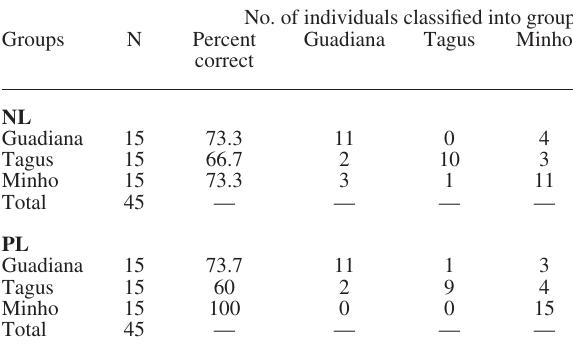
Table 4. – Classification results obtained with the stepwise discri- minant analysis cross-validation for neutral lipid (nl) and polar lipid (Pl) fatty acids to determine the predictive accuracy level of the discriminant